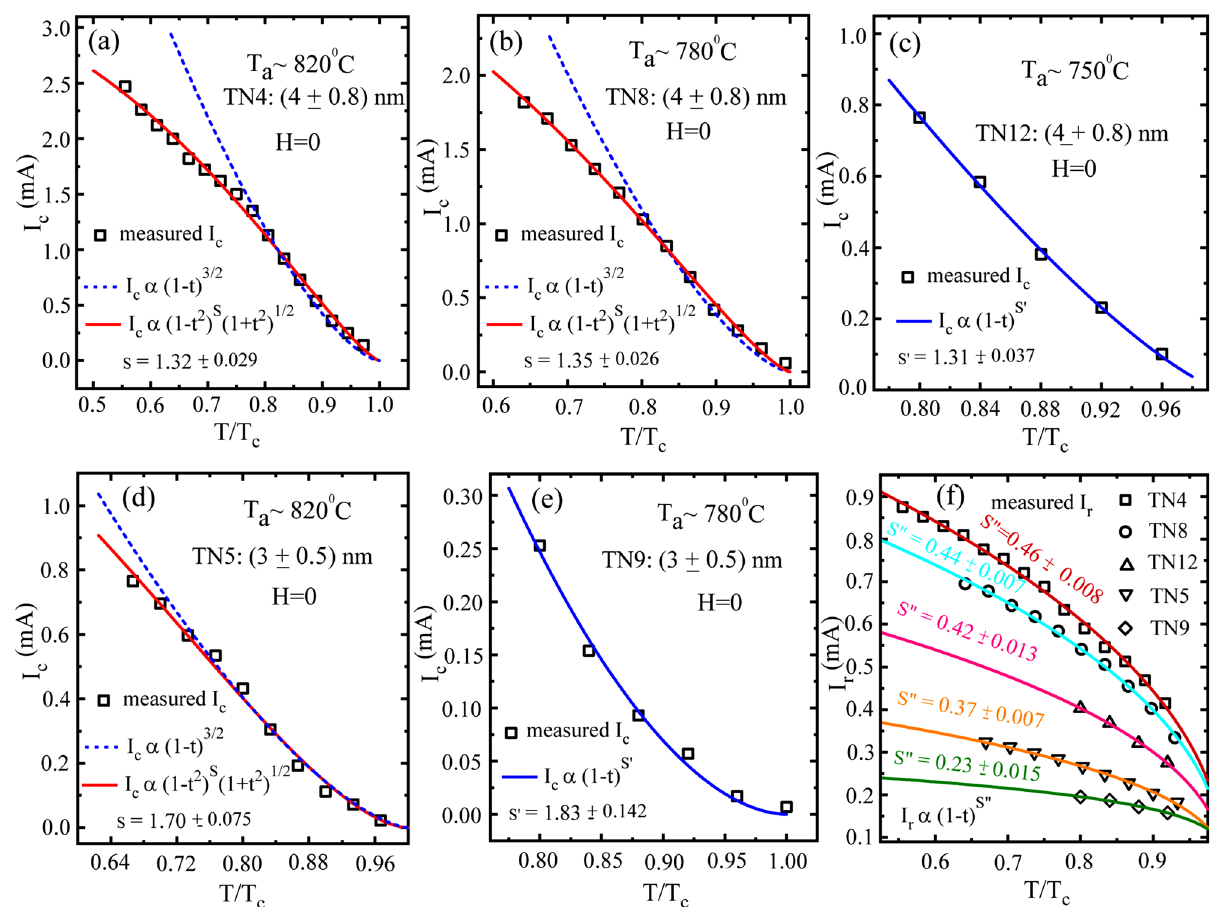
Figure 6. Temperature dependence of characteristic currents such as critical current ( I c ) and retrapping current ( I r ). Dependence of I c on reduced temperature ( T/T c ) for samples ( a ) TN4 annealed at 820 °C, ( b )TN8 annealed at 780 °C, ( c )TN12 annealed at 750 °C, ( d )TN5 annealed at 820 °C and ( e )TN9 annealed at 820 °C. The samples in the first row, ( a – c ), are having the same film thickness of about 4 nm, whereas, the samples presented in ( d , e ) are having thickness of about 3 nm. The blue dotted lines indicate the fitting on the experimental data points close to the T c by using the Ginzburg–Landau (GL) eqn. I c ∝ ( 1 − t ) 3 / 2 , where t = T / T c . The red solid lines s ( 1 + t 2 ) 1 / 2 , fitted over the entire range of are the fits obtained by using the modified GL eqn. I c ∝ ( 1 − t 2 ) measured temperature. However, blue solid lines in ( c , e ) give the best fit by using the GL equation with a free exponent s ′ instead of fixing it to 3/2 for samples TN9 & TN12 at temperature close to the T c . ( f ) I r related to all the five samples TN4, TN5, TN8, TN9 and TN12. For I r , SBT model was used to fit the experimental data and s ′′ the solid-colored lines represent the fitted curves by using eqn. I r ∝ ( 1 − t ) measured the temperature dependent I r for all the above five samples and the collection of those is presented in Fig. 6f. First, we observe that the amplitude of I r reduces with the reduction in T a for the samples having same thickness. Similarly, reduction in thickness also reduces the I r for samples annealed at same T a . Therefore, I c and I r follow the similar trend as that of T c with the variations in thickness and T a . In the present case due to hyster- etic IVCs, I c and I r are different and this is mainly due to the Joule heating in the resistive state 38CitationID="CR39">39 . s ′′ , Therefore, we have used the SBT hotspot model using equation, I r ∝ ( 1 − t ) to fit the retrapping current. Here, s ′′ = 1 / 2 is the theoretical value. The best fitted colored curves, using the exponent s ′′ as a free parameter, are presented in Fig. 6f for individual samples. The exponent for the samples TN4 ( s ′′ = 0.46 ) , TN8 ( s ′′ = 0.44 ) & TN12 ( s ′′ = 0.42 ) are close to the theoretical value of 0.5, whereas, there is a small deviation from the theoreti- cal value for the sample TN5 ( s ′′ = 0.37 ) and a further deviation appears for TN9 ( s ′′ = 0.23 ) . The deviation in